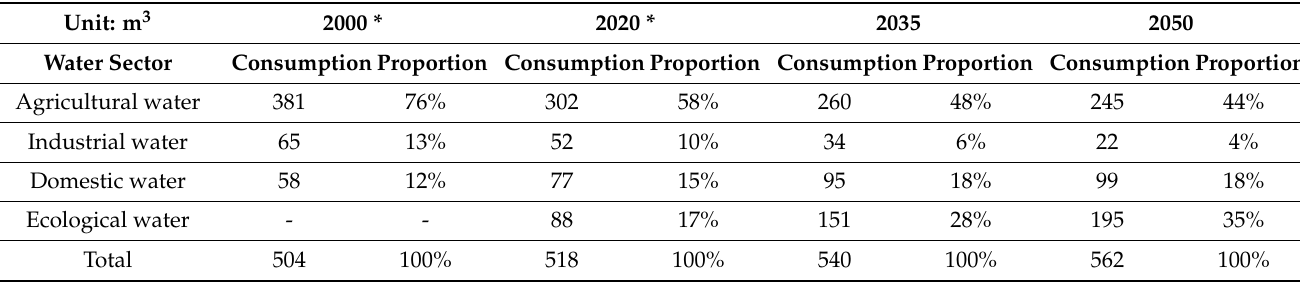
Table 4. Water resources utilization structure in North China.